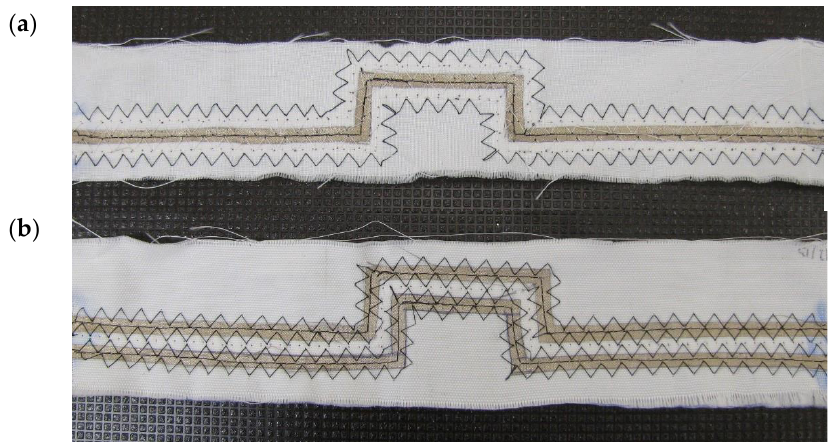
Figure 2. Signal lines produced by sewing technique. View from the side of the signal path ( a ), view from the side of the ground paths ( b ).